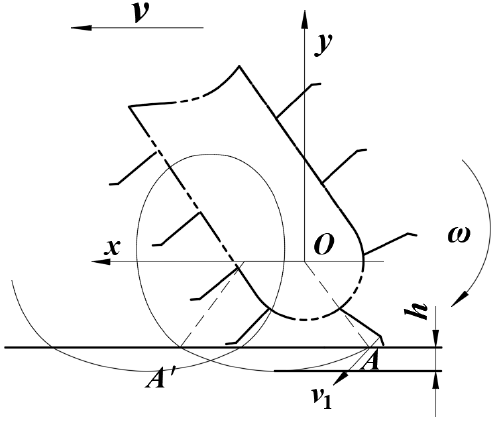
Figure 8. The motion trajectory of the pickup hook